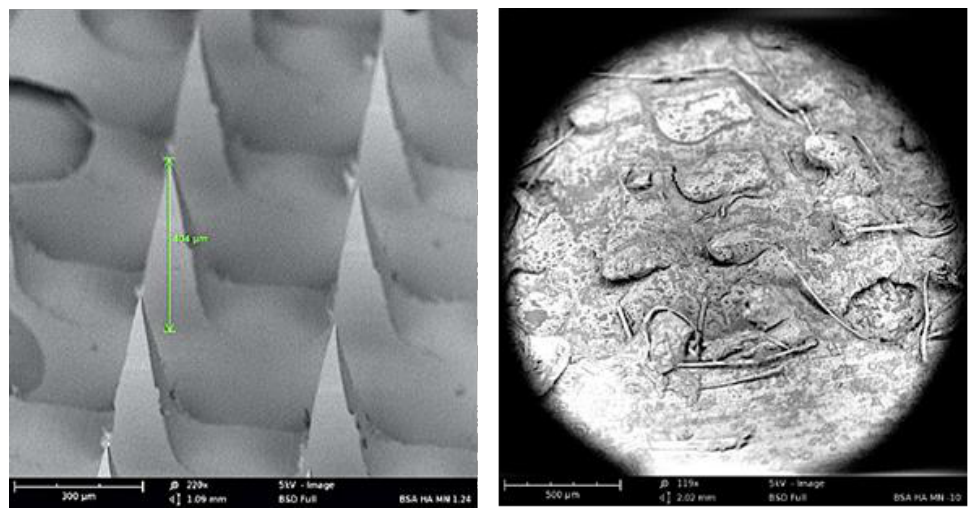
Figure 1. SEM image of dissolving microneedle: ( left ) before application and ( right ) 5 min after application to murine skin.